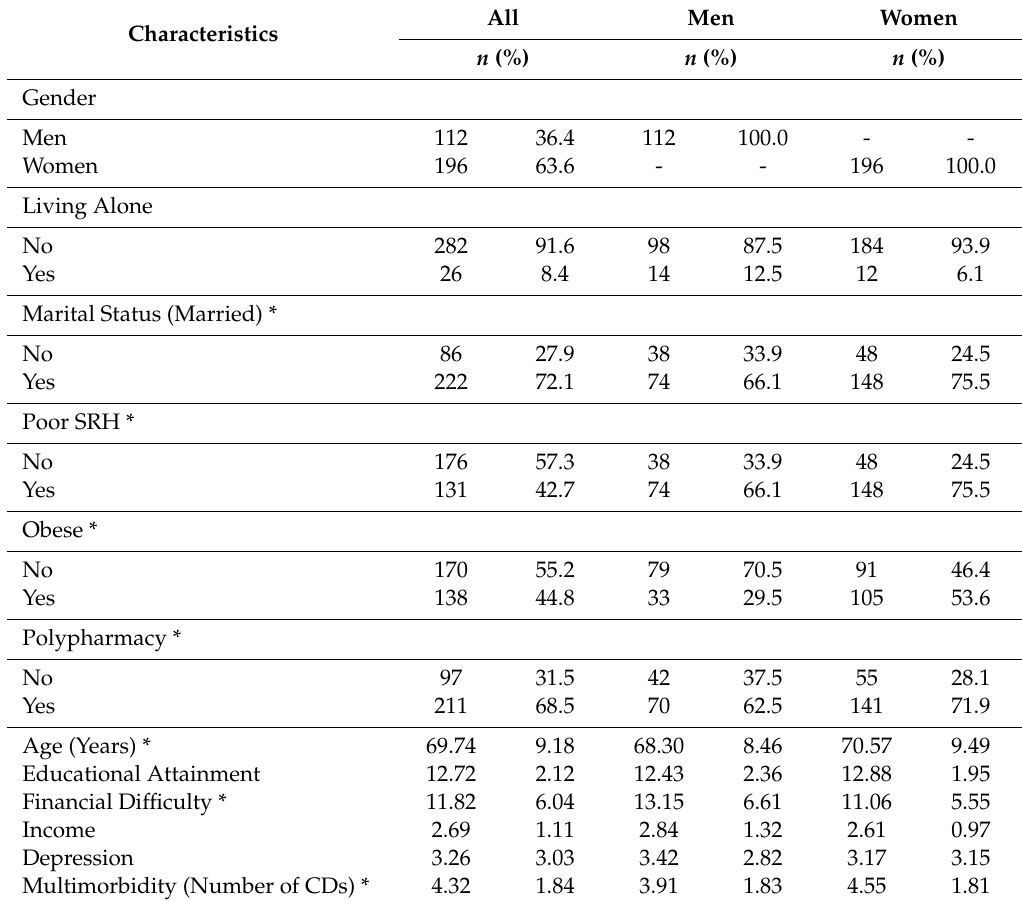
Table 1. Descriptive characteristics in the pooled sample and by